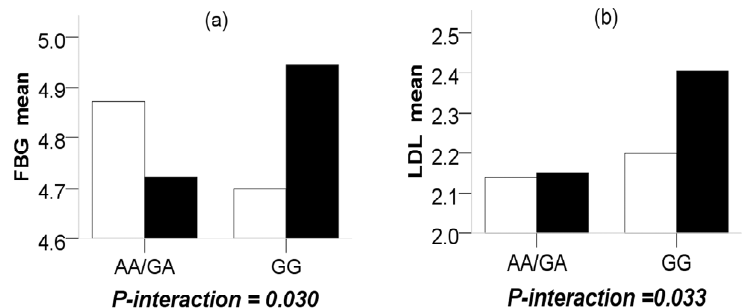
Figure 2. ( a ) The interaction ( P = 0.030) between the CMTM7 rs347134 polymorphism and the nuts and sweets-based dietary pattern (NSDP) on FBG ( P = 0.040 and 0.031 between the first and last quartile in AA / GA and GG, respectively); ( b ) the interaction ( P = 0.033) between the CMTM7 rs347134 polymorphism and the AFDP on TG ( P = 0.243 and 0.038 between the first and last quartile in AA / GA and GG, respectively).